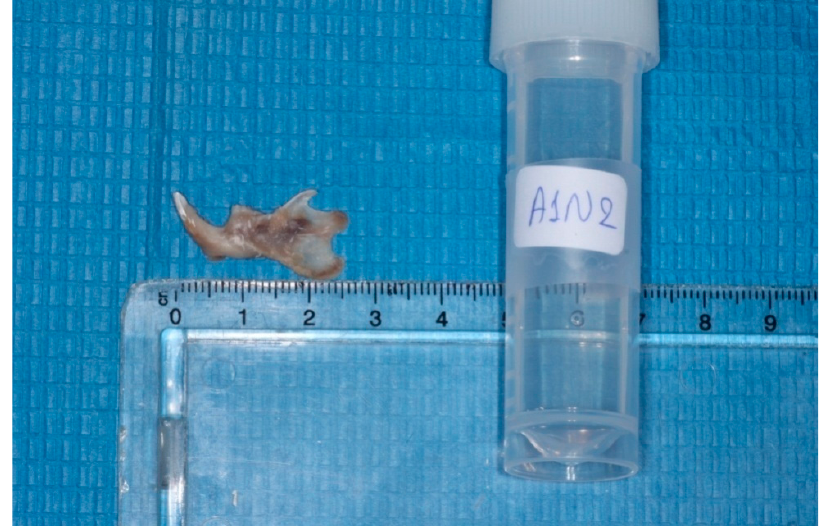
Figure 2. Isolation of the mandibles.